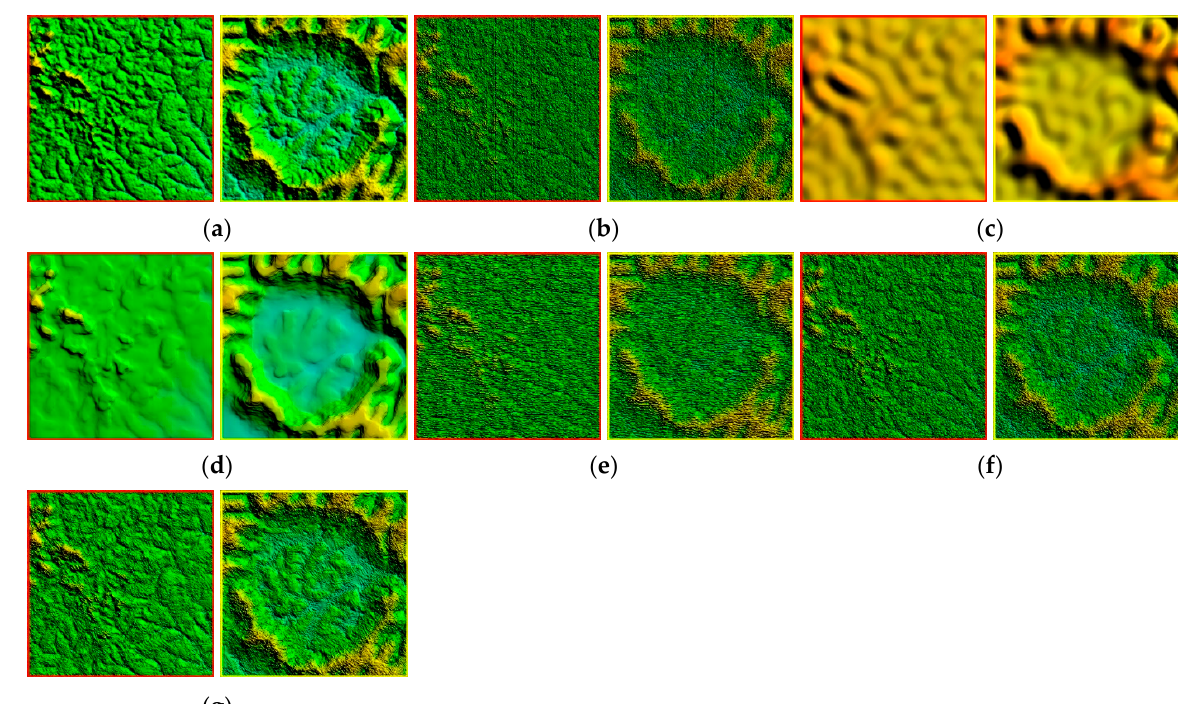
Figure 5. Results of the simulation experiment for area N01E12 with vertical stripes and random-noise mixing errors (unit: meter). ( a ) Original N01E12 area (PSNR, SSIM), ( b ) mixed error (30.01, 0.5511) added, ( c ) low-pass filter (29.19, 0.4322), ( d ) total variation (TV) (30.76, 0.5460), ( e ) Unidirectional Total Variation (UTV) (29.95, 0.5179), ( f ) Low-Rank based Single- Image Decomposition (LRSID) (30.48, 0.6617) and ( g ) low rank group-sparse method (LRGS) (30.94, 0.8319).